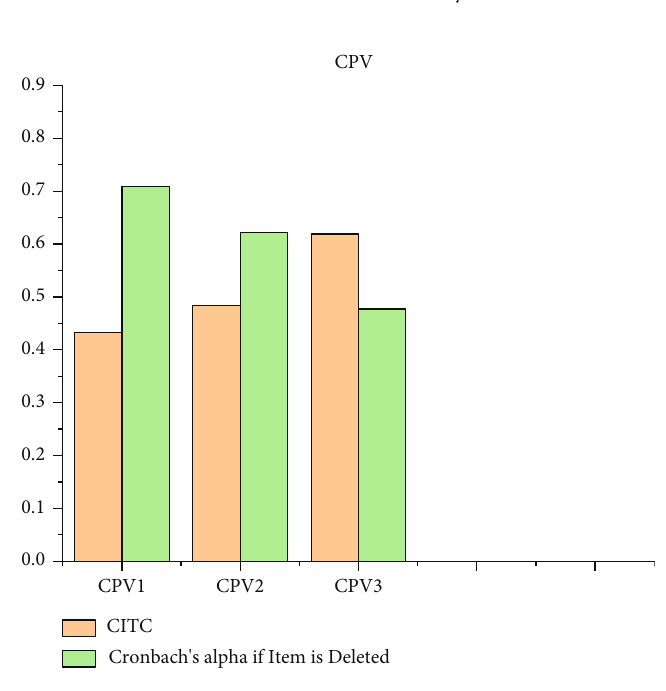
Figure 5: Results of RES analysis.